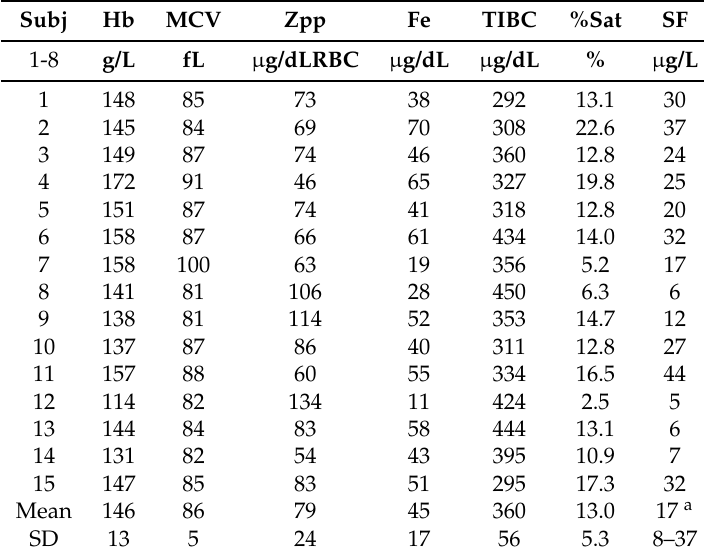
Table 2. Iron nutrition status of study